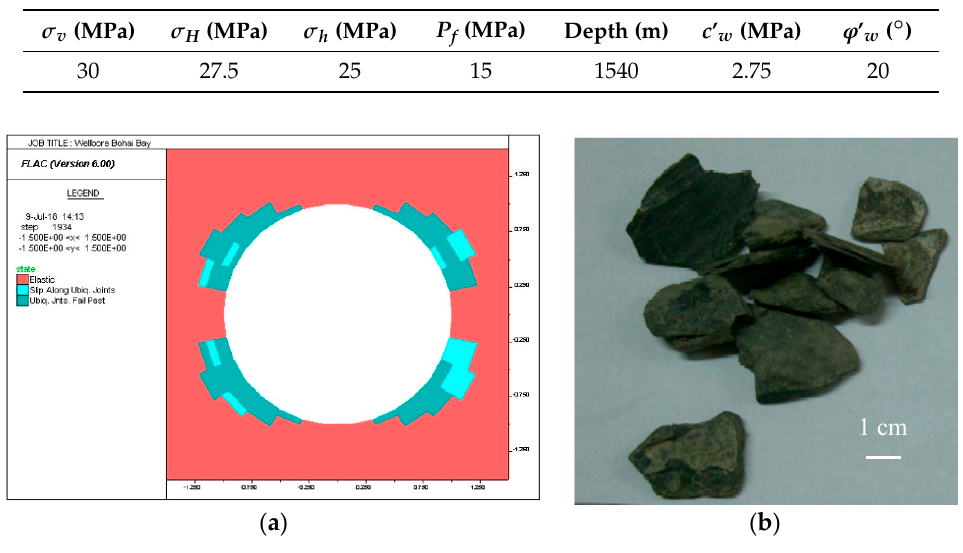
Table 5. Data used for the calculation of mud pressures in a horizontal wellbore drilled in Bohai Bay (China) [8].